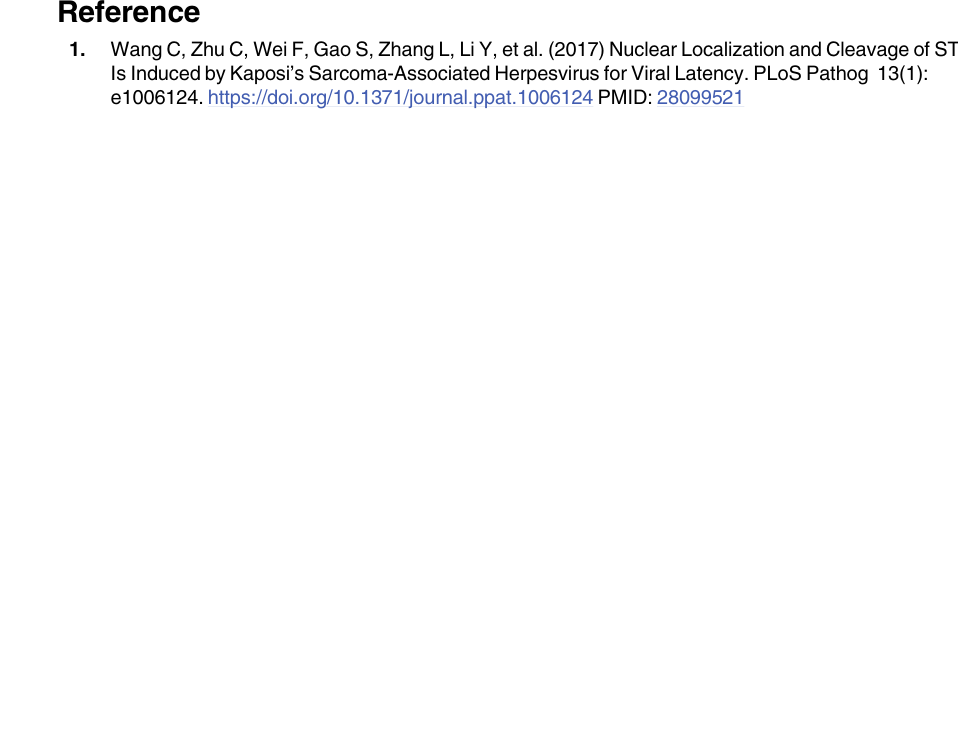
S5 File. Original data underlying results presented in S1 Fig. S6 File. Underlying individual level data for Figs 1, 7, and 8. S7 File. Underlying blots and images for Figs